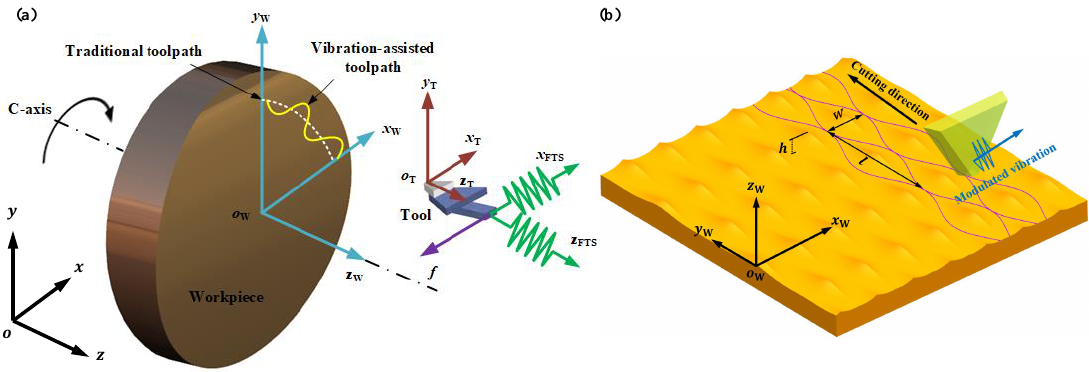
Figure 1. Dual-axial tool servo diamond turning: ( a ) Basic principle; ( b ) Fabricating the secondary